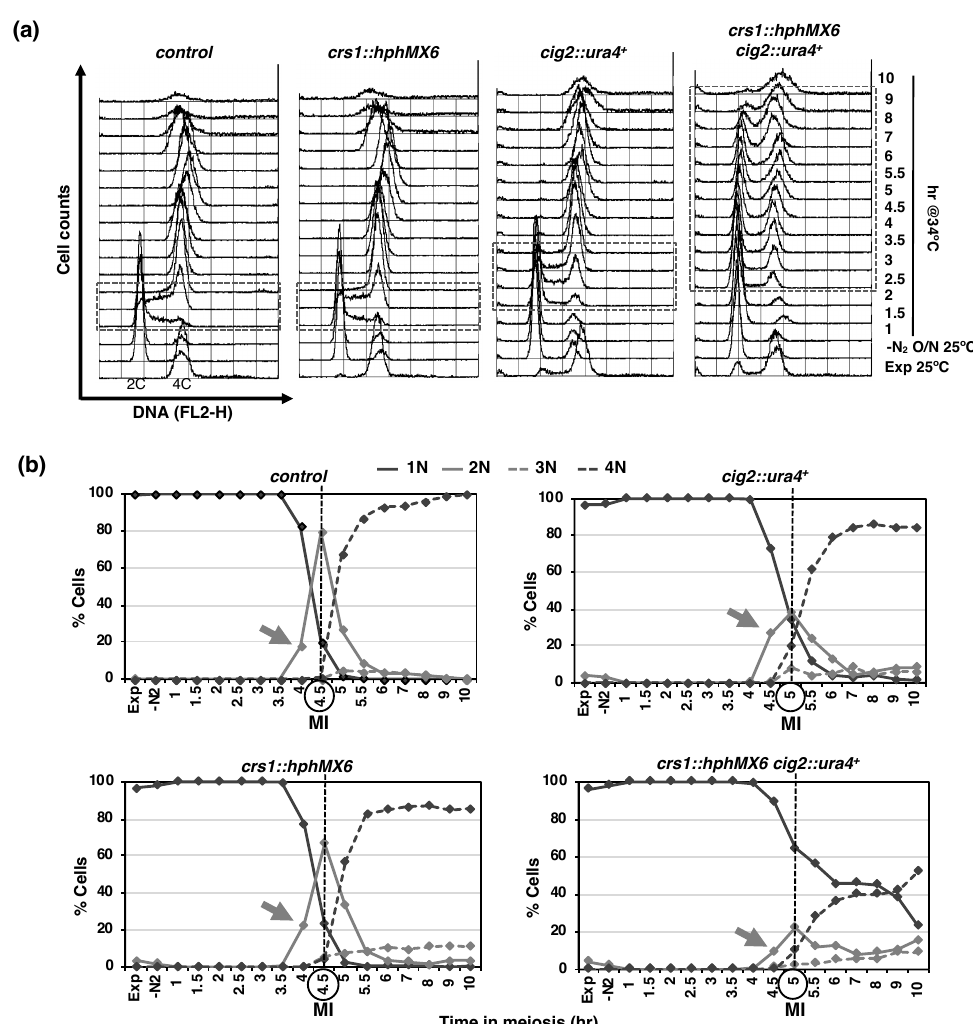
Figure 4. Meiosis progression of cig2 and crs1 mutants. ( a ) Flow cytometry analysis of synchronous diploid pat1-114 meiosis of control (CMC1074), crs1 (CMC1059), cig2 (CMC1022), and double crs1 cig2 (CMC1131) deletion mutants. DNA content (FL2-H) histograms are shown. Dashed-lined box outlines S-phase progression. ( b ) Quantification of chromosome segregation by DAPI staining and nuclear counting (1 nucleus, 2 nuclei, 3 nuclei, and 4 nuclei) is shown. The arrows indicate meiosis I (MI) entry, and the vertical dashed-lines indicate the peak of MI. Related to Figure